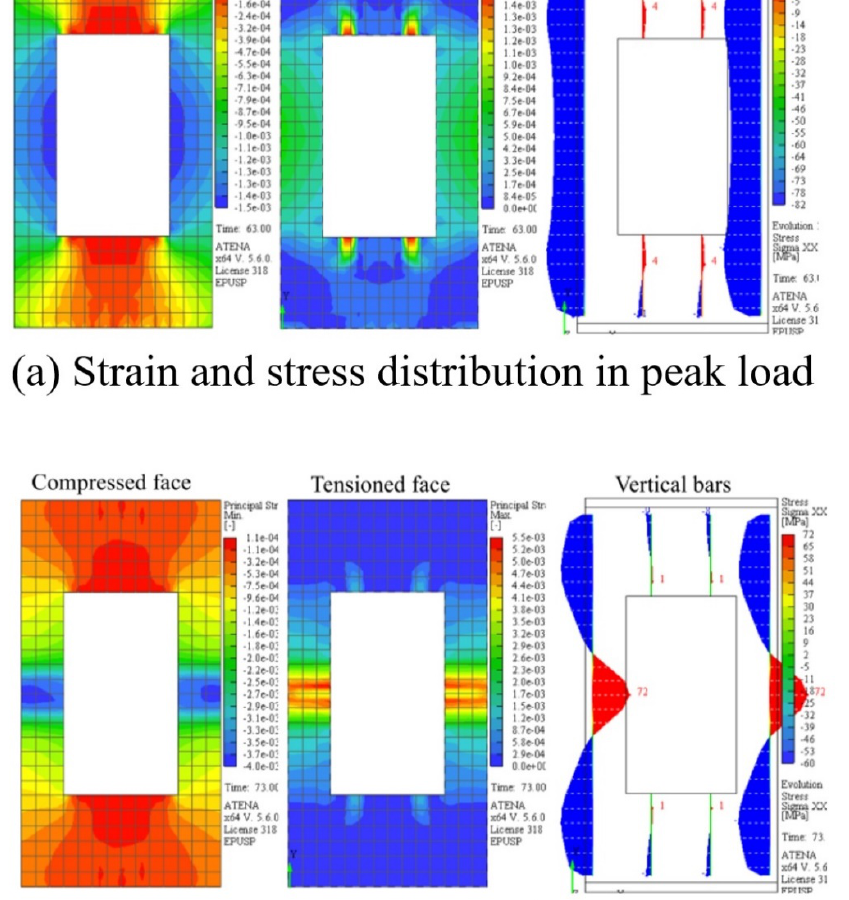
Figure 12. Collapse of non-strengthened numerical models